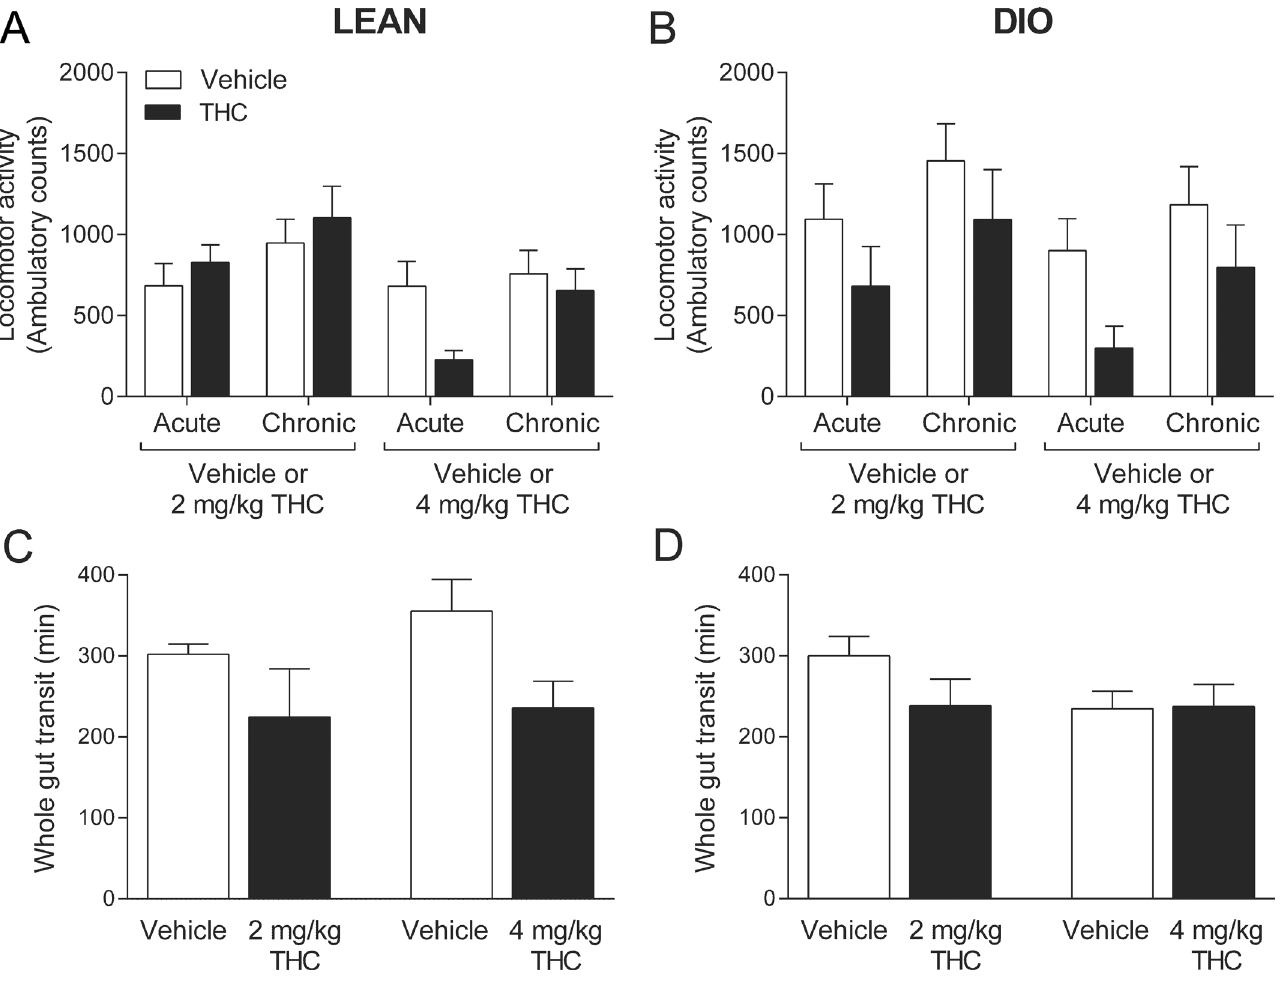
Fig 2. THC has no effect on locomotor activity or whole gut transit. The effect of daily administration of Δ 9 -tetrahydrocannabinol (THC) or vehicle on locomotor activity ( A , B ) in lean or diet-induced obese (DIO) mice recorded between 13:00 – 16:00, 20 mins after the daily treatment injection (Acute)